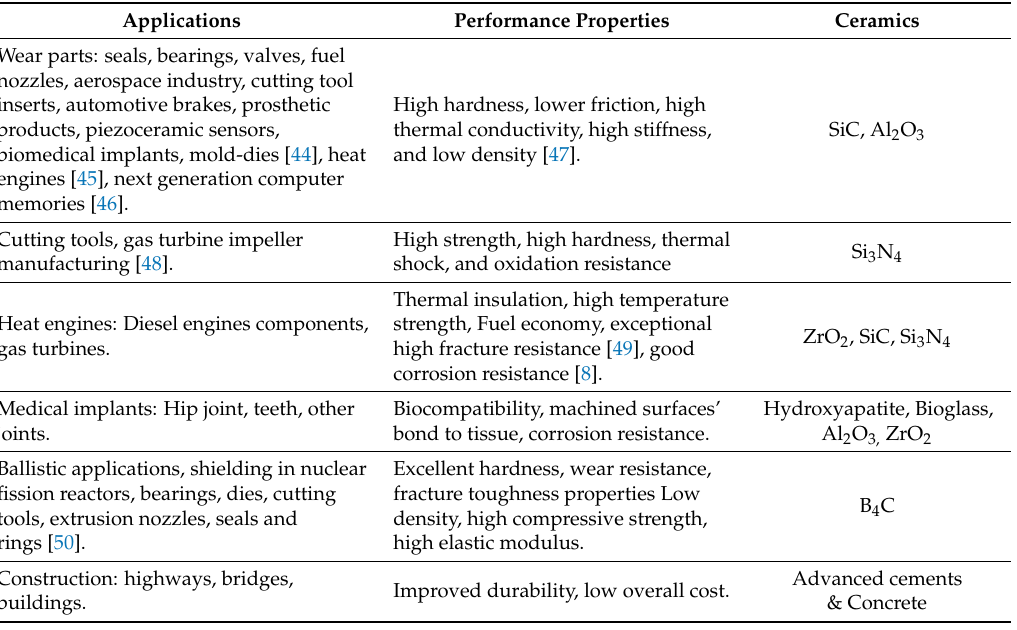
Table 1. Application & properties of ceramics materials [2].